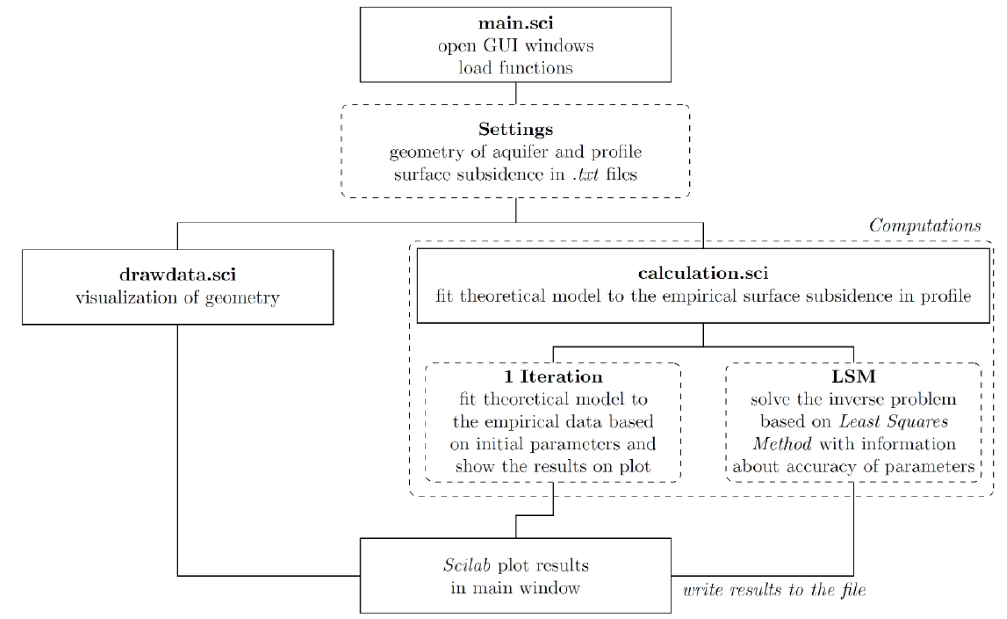
Figure 3. The framework of the SubCom v1.0 program.